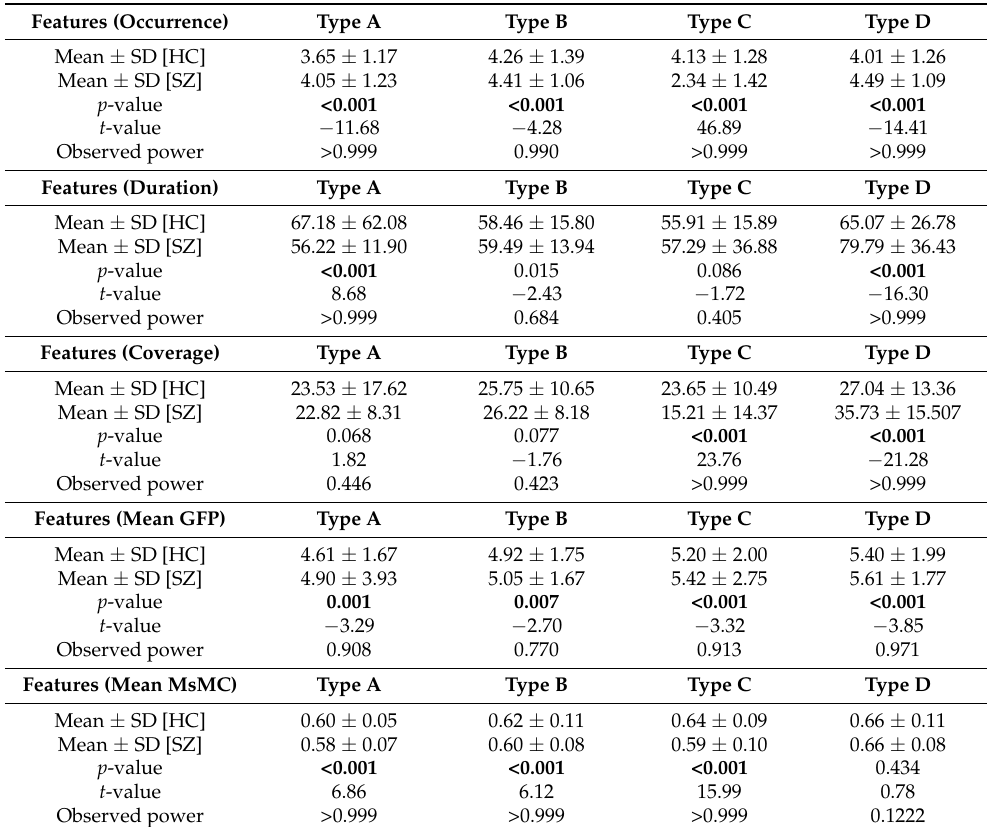
Table 2. Univariate analysis results of the microstate